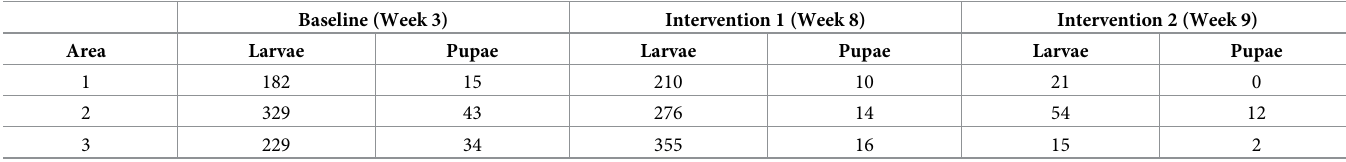
Table 3. Effect of insecticide intervention on the abundance of immature Aedes aegypti at the study area in Miami-Dade County, Florida, from June 7th to Septem- ber 27th,